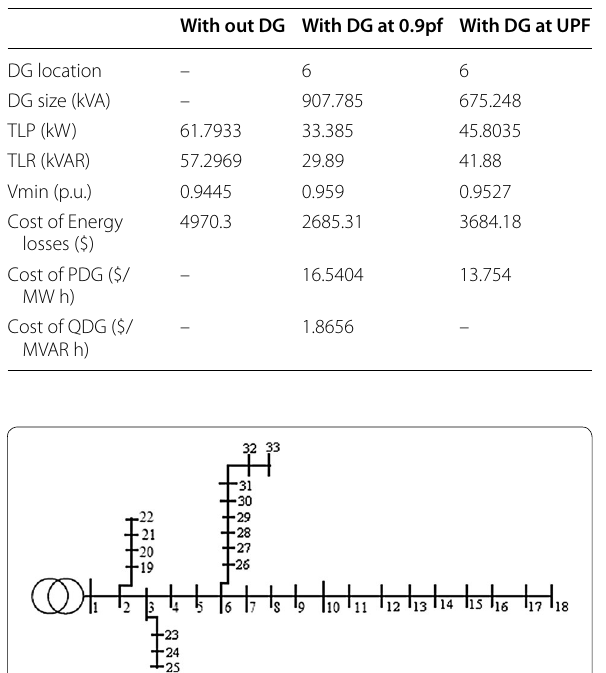
Fig. 3 Single-line diagram of 33-bus